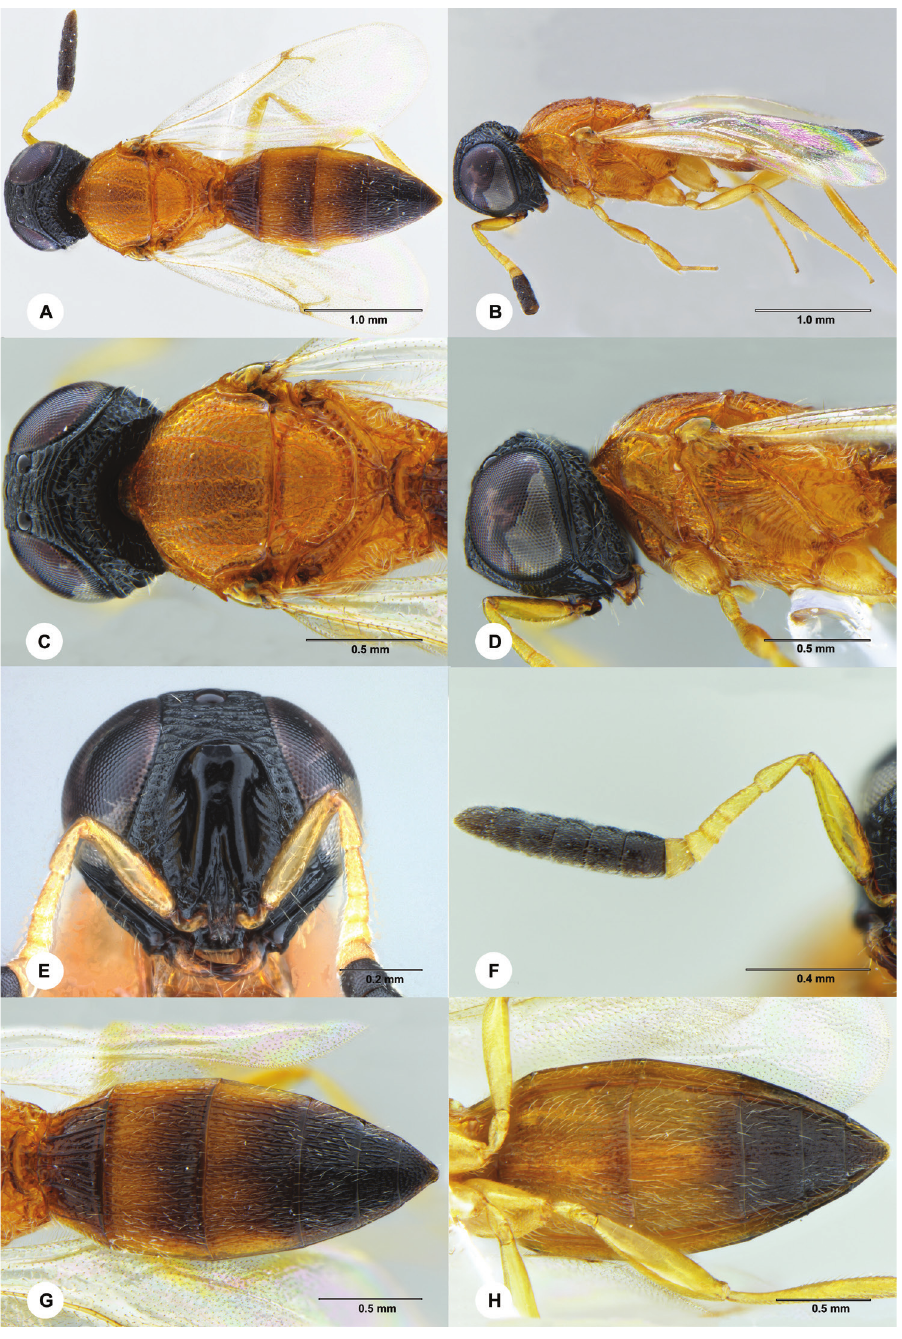
Figure 4. Oxyscelio latheticus Mo & Chen, sp. nov., holotype, female (SCAU 3049073) A dorsal habitus B lateral habitus C head and mesosoma, dorsal view D head and mesosoma, lateral view E head, anterior view F antenna G metasoma, dorsal view H metasoma, ventral